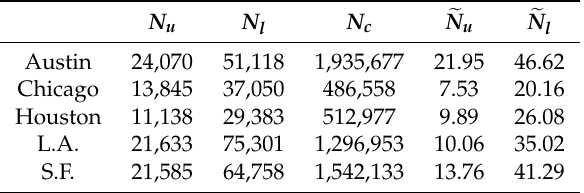
Table 1. The statistics of experimental